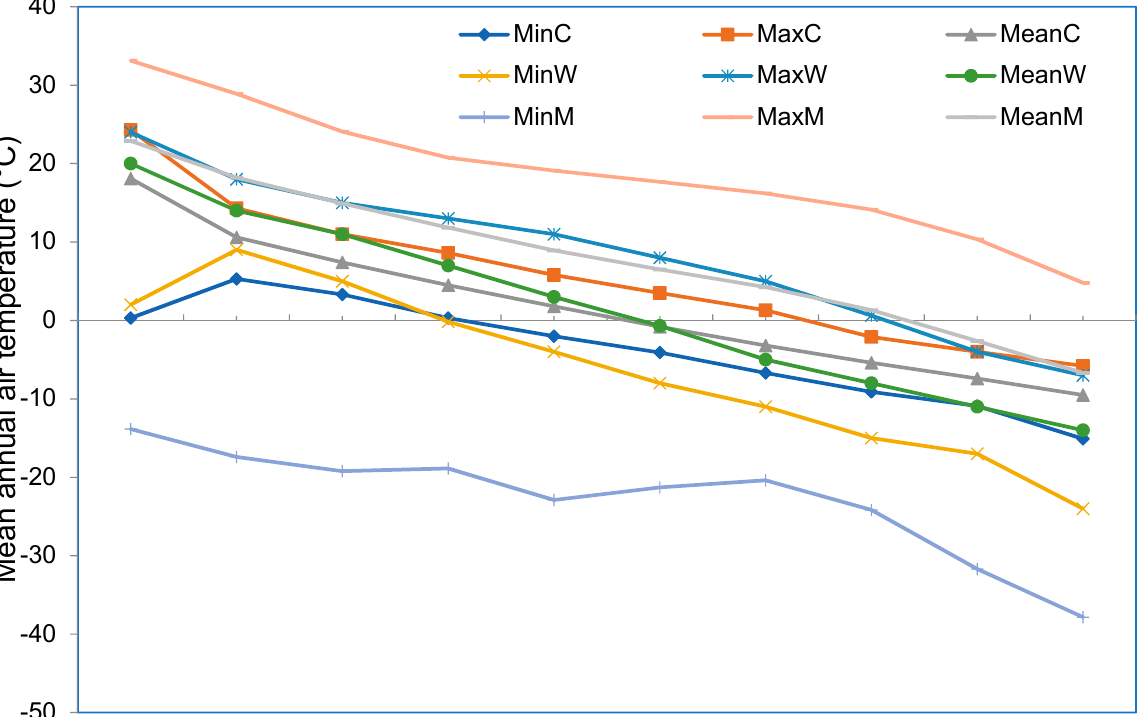
Figure 12. Minimum, maximum and mean values of mean annual air temperature (BIO1) obtained for each elevation section using WorldClim 2.0, CHELSA and MODIS observations. Here, MinC, MaxC and Mean C represent minimum, maximum and mean values of mean annual air temperature obtained for each elevation section using CHELSA. Similarly, MinW, MaxW and MeanW represent minimum, maximum and mean values of mean annual air temperature obtained for each elevation section using WorldClim 2.0. Correspondingly, MinM, MaxM and MeanM represent minimum, maximum and mean values of land surface temperature obtained for each elevation section for the period from 2001 to 2017 using MODIS observations.